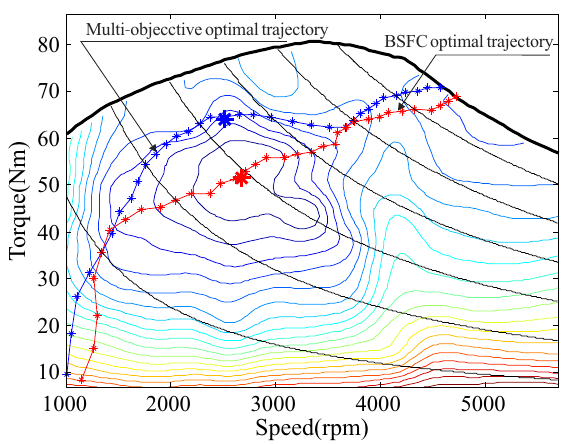
Figure 7. Multi-objective optimal trajectory and the brake specific FC (BSFC) optimal trajectory.